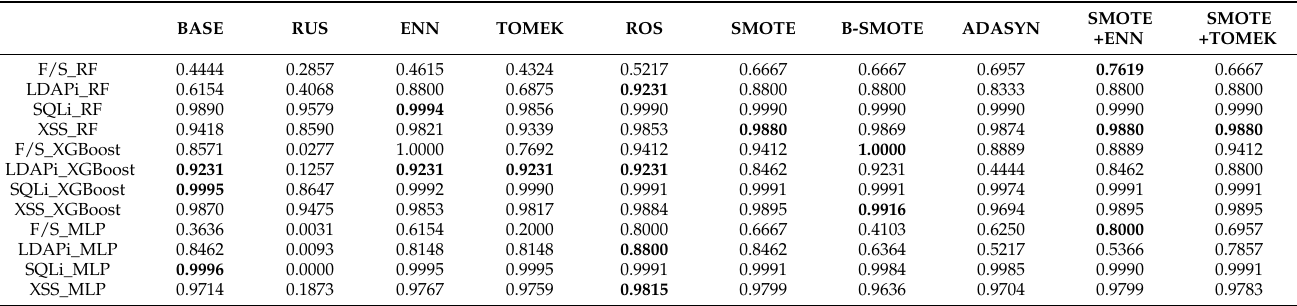
Table 9. Model performance results after sampling (dataset CSIC2012, F 1- score